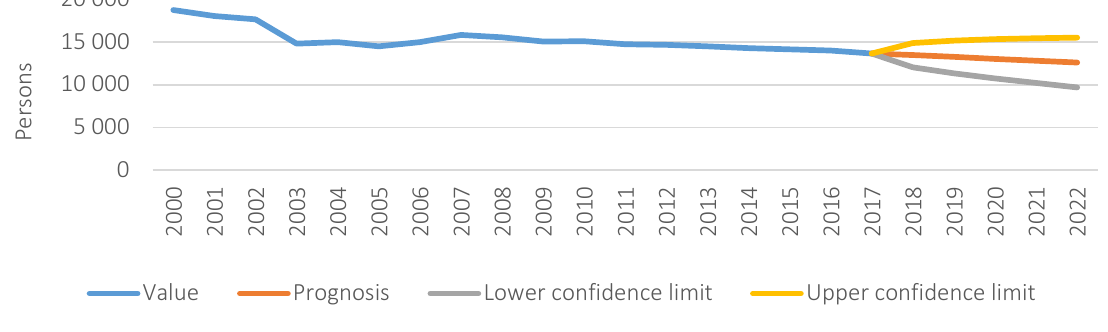
Figure 3. Prognosis of the development of the number of physicians in productive age in the SR until